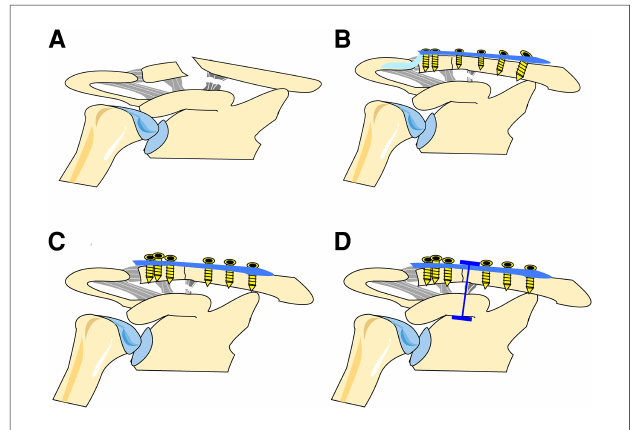
FIGURE 1 Three different fi xation techniques for the treatment of Neer type IIb distal clavicle fractures. ( A ) Neer type IIb distal clavicle fractures; ( B ) HP group; ( C ) LP group; ( D ) LPSB group. HP, hook plate; LP, locking plate; LPSB, locking plate with a suture button.